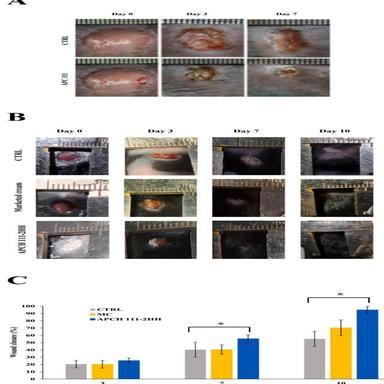
In vivo effects of in situ gelling powders on the wound healing of a murine model. Panel A: Representative photographs of wound spot at days 0, 3, and 7 taken after full-thickness skin excision, APC 111 vs normal healing control just with antibiotic application on day 0. Panel B: representative macroscopic registration of wound healing at different time intervals, APCH 111-2HH vs normal healing control just with antibiotic application on day 0 vs marketed wound healing cream; Panel C: normalized wound closu